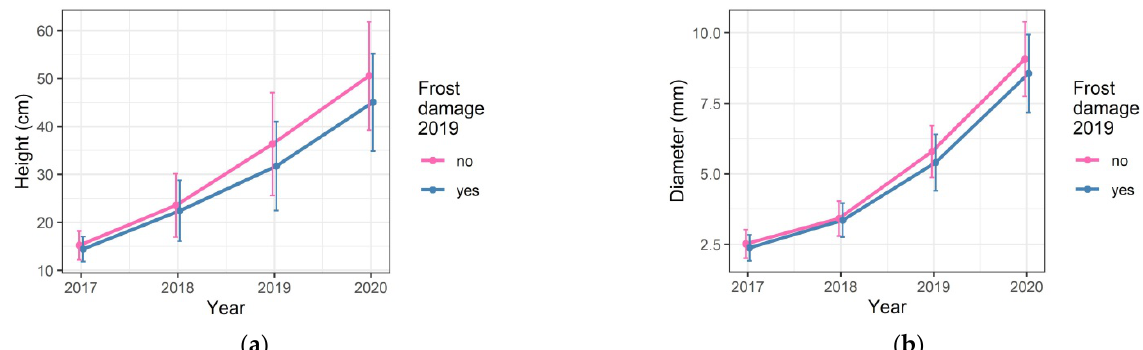
Figure 7. Mean and standard deviation for height ( a ) and diameter ( b ) of the plants from 2017 to 2020 according to the frost damage that occurred in the spring of 2019.